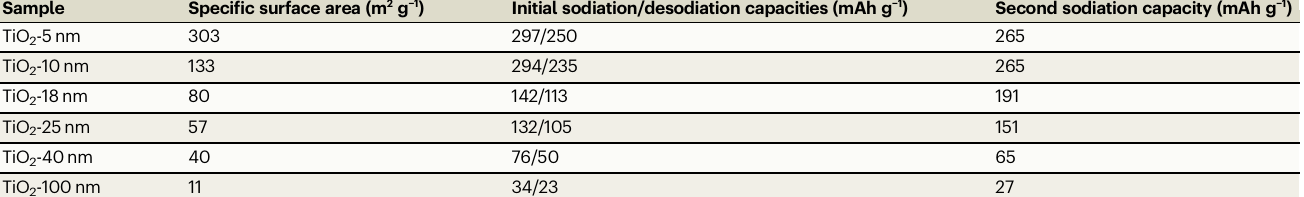
Table 1 | The speci fi c surface area and sodium-ion storage performance of different TiO 2 NPs at 0.1 A g − 1 (0.15 mA cm − 2 )